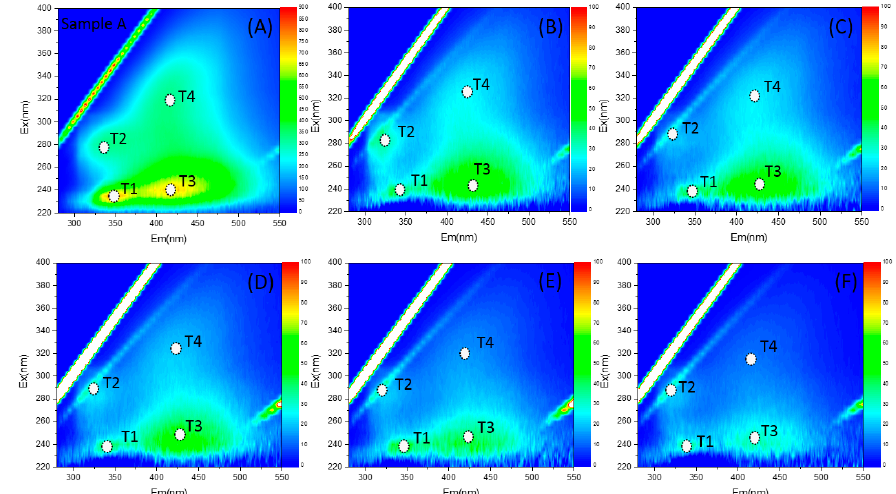
Figure 1. EEM spectra of sample A before ( A ) and after ozonation ( B ), catalytic ozonation by the catalysts ( C–F ) with fluorescence regions and peak maxima indicated for humic-like substances (Ex: 300–370 nm, Em: 400–500 nm), fulvic-like substances (Ex: 237–260 nm, Em: 400–500 nm) and protein-like structures (Ex: 235–240 nm, Em: 340–355 nm; Ex: 280–285 nm, Em: 320–335 nm).